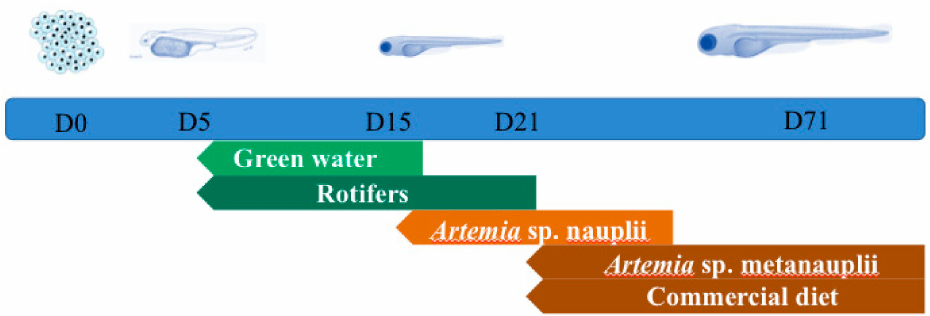
Figure 1. Experimental design and trophic stages from day zero (D0) to day 71